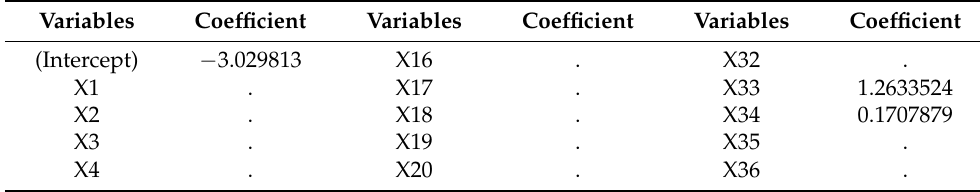
Figure 2. Plot for LASSO regression. The coefficients are measured on the y − axis. The penalty term is measured on the x − axis. Every colorful line represents the change in a variable in the regression. As the penalty term increased, the coefficients of most variables were shrunk to zero. Table 2. The coefficients screened by the LASSO